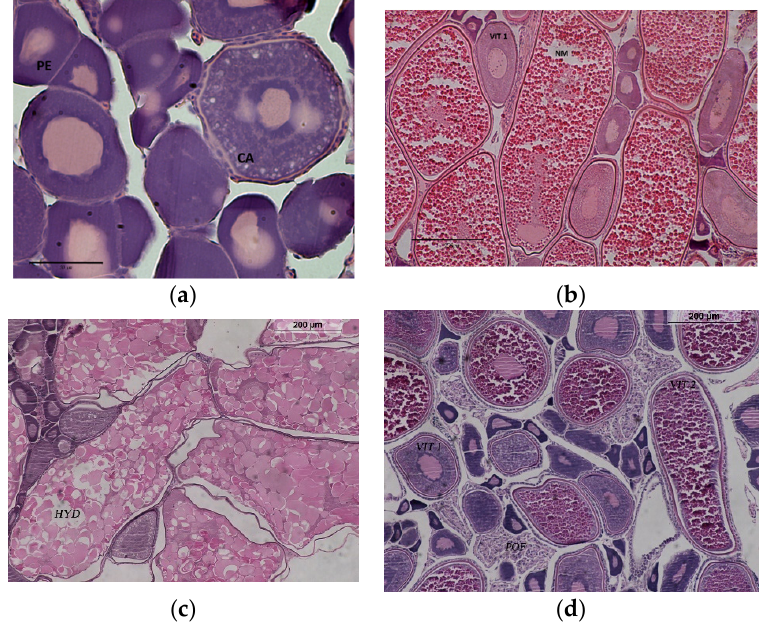
Figure 2. Histological sections of anchovy ovary. Different reproductive phases were displayed: ( a ) Developing; ( b ) Imminent spawning; ( c ) Spawning; ( d ) Partial post-spawning (defined according to Ferreri et al. [34]). Different oocyte development stages were also highlighted. PE = perinucleolar oocyte stage; CA = cortical alveoli; VIT1 = partially vitellogenic oocytes; VIT 2 = fully vitellogenic oocytes; NM = nucleus migration; HYD = hydrated oocytes; POF = post-ovulatory follicle. Scale bar: image “a” bar = 50 μ m; images “b–d” bar = 200 μ m.